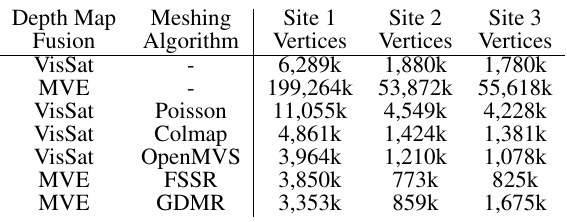
Table 5. Number of vertices reconstructed with the different point fusion and mesh triangulation algorithms for each